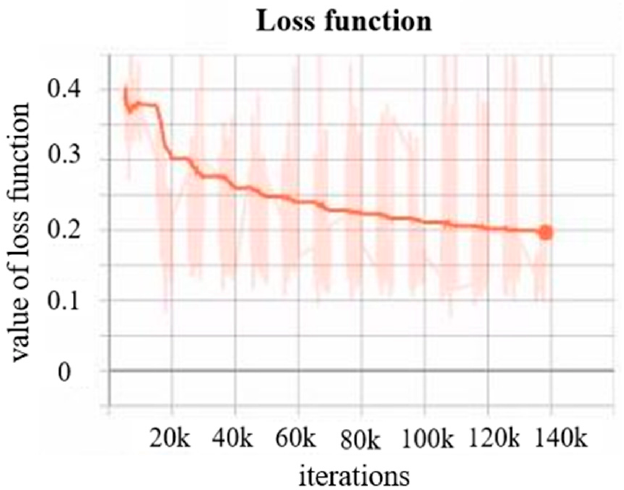
Figure 33. The graph showing the loss function.